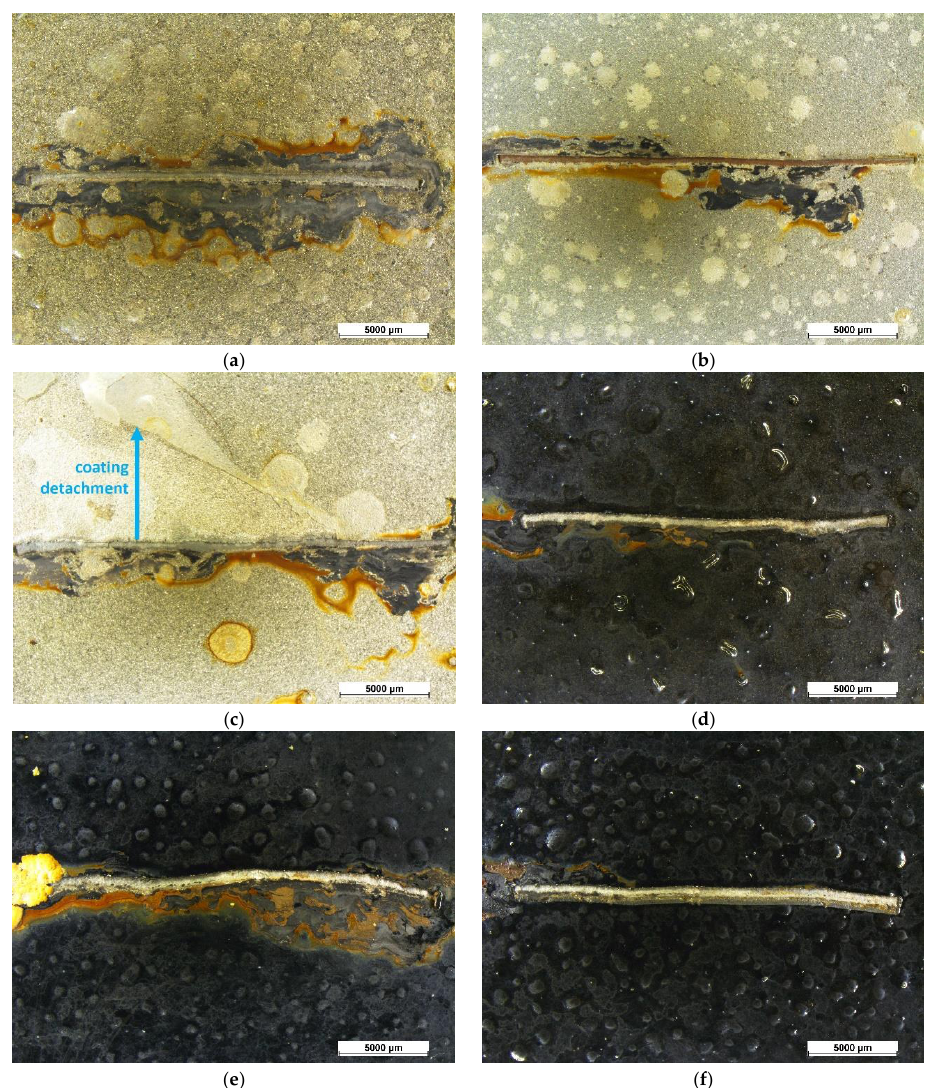
Figure 7. Samples C ( a ), CfGO ( b ), S ( c ), SG ( d ), C-SG ( e ) and CfGO-SG ( f ) behavior in salt spray test, after the removal of the corrosion